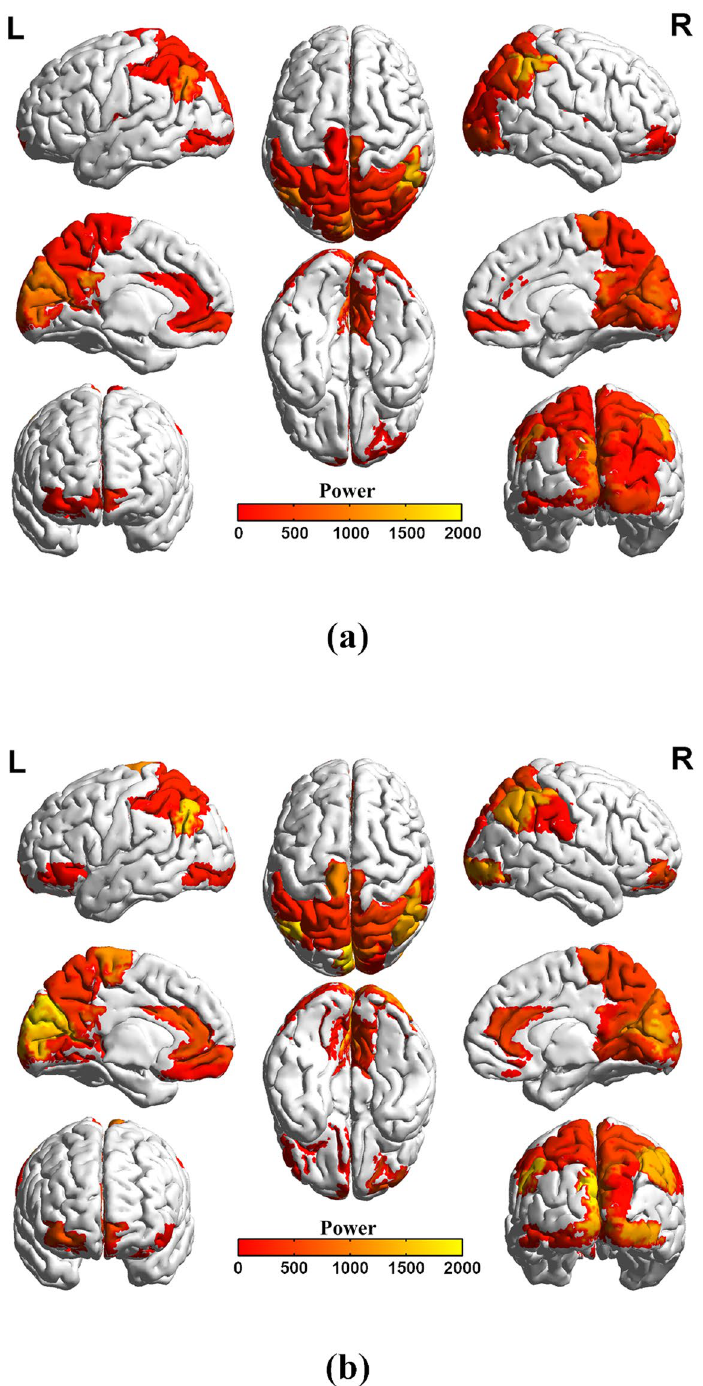
Figure 1. Network distribution of brain power with a nonparametric estimate p < 0.05: ( a ) CD; ( b ) TD. Panels (a,b) were generated by introducing the significant power values into the BrainNet Viewer (http://www.nitrc. org/projects/bnv/) tool